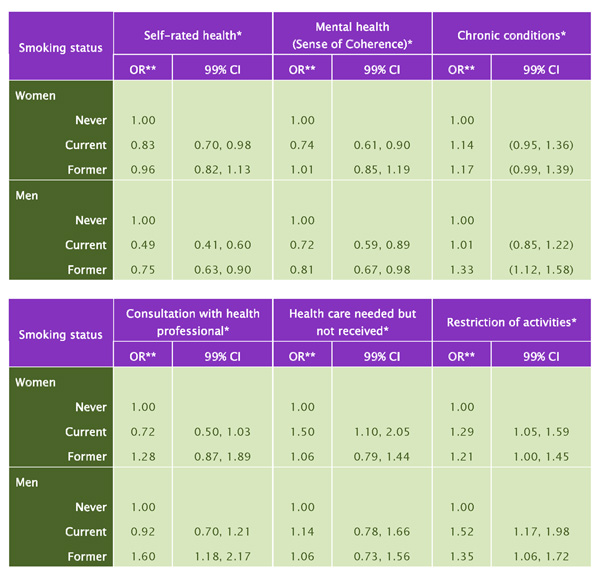
Multivariate Associations Between Smoking Status and Current Health Indicators, by Sex (NPHS 1998–1999)*Adjusted for age, marital status, visible ethnic minority, education, income adequacy, household type and functional social support  **Odds ratio